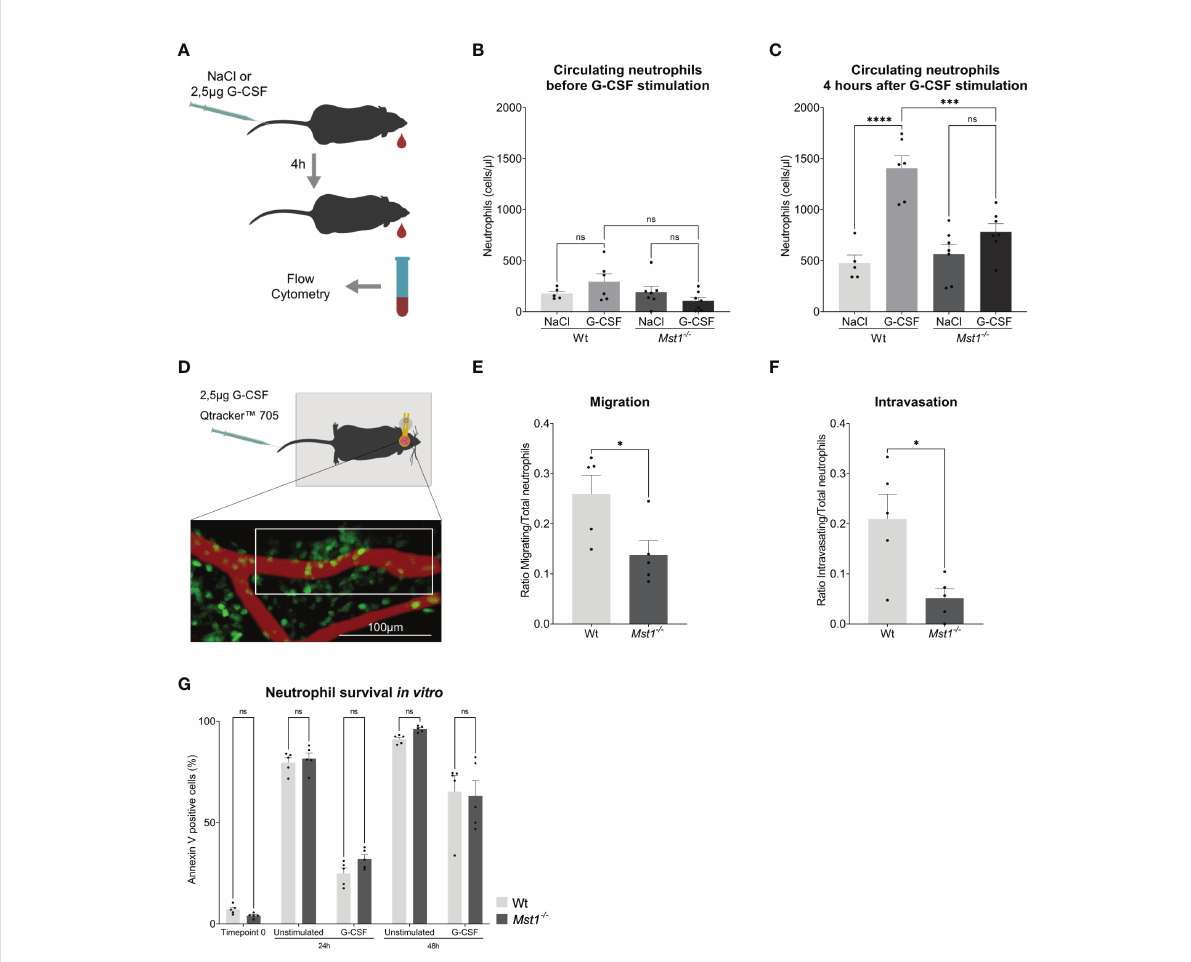
FIGURE 2 Mst1 -/- neutrophils show an impaired response to G-CSF stimulation. (A) Schematic representation of the neutrophil release assay. (B, C) Flow cytometry analysis of blood circulating neutrophils before and after G-CSF stimulation; n=5-7. (D) Schematic representation of the two-photon skull imaging. The highlighted area of analysis is 70x170 m m. (E, F) Number of cells migrating (E) and intravasating the vessel (F) relative to the total number of cells at T 0 in the area of analysis; n=5. (G) Flow cytometry analysis of Annexin V staining in unstimulated and G-CSF stimulated isolated neutrophils; n=5. One-way ANOVA; ns, non signi fi cant; ***p<0.001, ****p<0.0001 (B, C) , unpaired t-test; *p<0.05 (E, F) and two-way ANOVA (G)